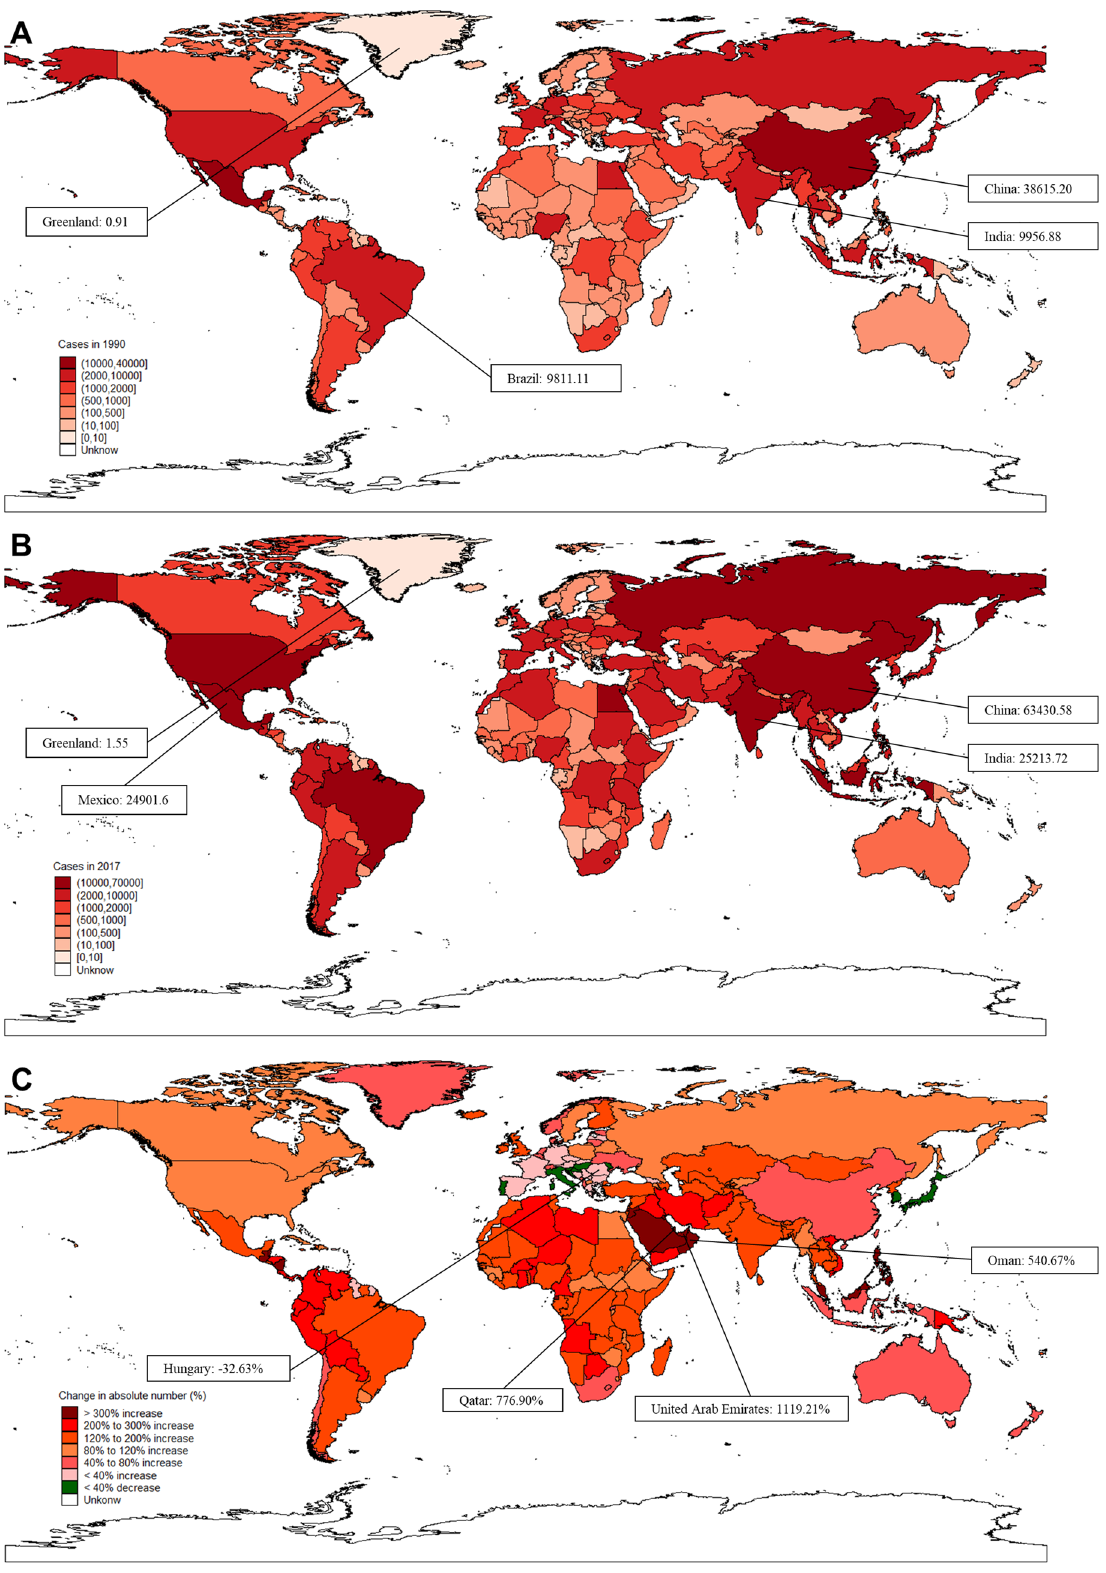
Figure 1. The overall incident cases of liver cirrhosis caused by NASH in 195 countries and territories. ( A ) The incident cases in 1990 across the world. ( B ) The incident cases in 2017 across the world. ( C ) The change in incident cases of liver cirrhosis caused by NASH from 1990 to 2017 across the world. Figures were created by STATA/MP 13.1 software. The SHP data of the world map were converted to STATA data via the “shp2dta” command, and maps were drawn via the “spmap” command after incorporating